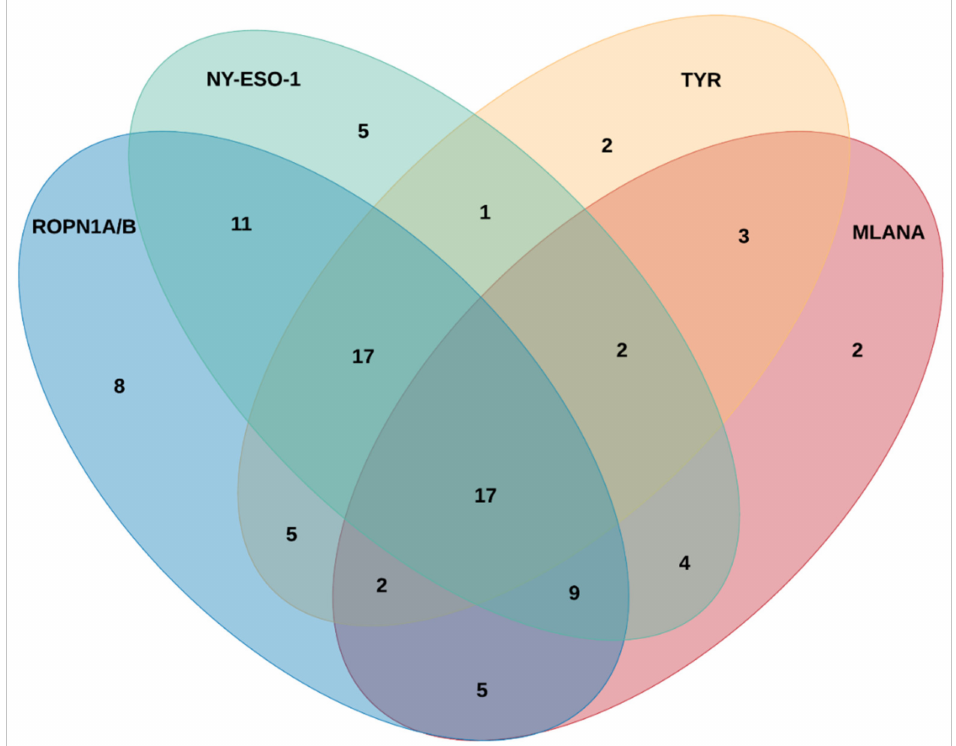
Figure 4. Venn diagram displaying predominance of ROPN1A/B, NY-ESO-1, TYR and MLANA-specific antibodies in melanoma patients. Antibody titres were measured in 104 melanoma patients using a custom protein microarray platform, and all resulting intensities above 500 RFU (defined noise threshold) were considered positive signals and plotted using a 4-way Venn diagram. RFU, relative fluorescent